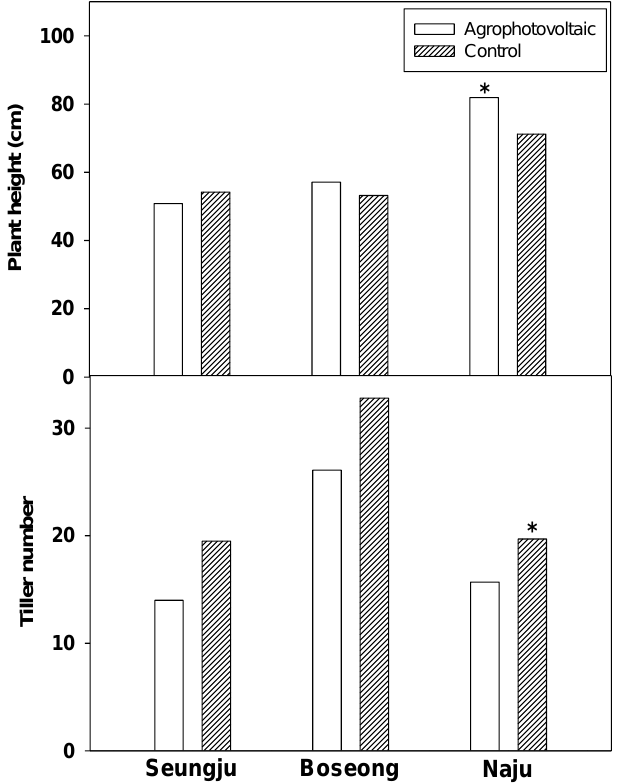
Figure 4. Growth of rice underneath agrophotovoltaic (APV) systems in different areas of South Korea. * significantly different between each APV system and control plot using a t -test ( p = 0.05). Table 7. Yield of rice underneath agrophotovoltaic (APV) systems in different areas of South Ko- rea.